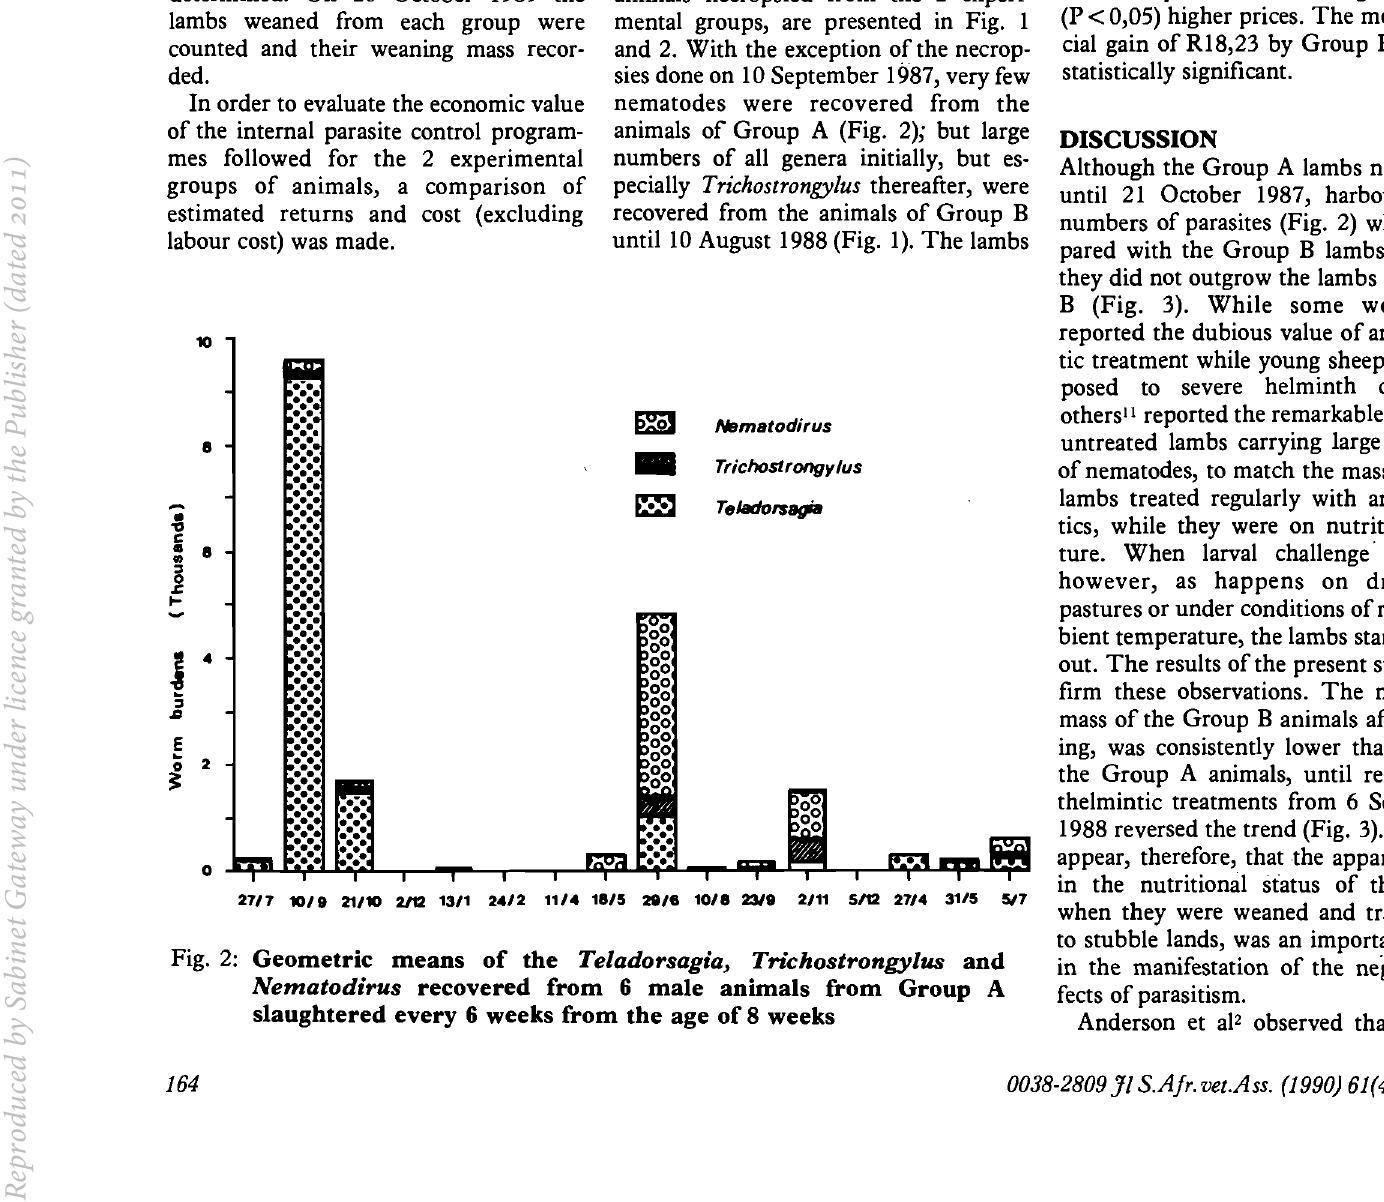
Fig. 1: Geometric means of th~ Teladorsagia, Trichostrongylus and Nematodirus recovered from 6 male animals from Group B slaughtered every 6 weeks from the age of 8 weeks value of each fleece by the mass of wool produced by that ewe.